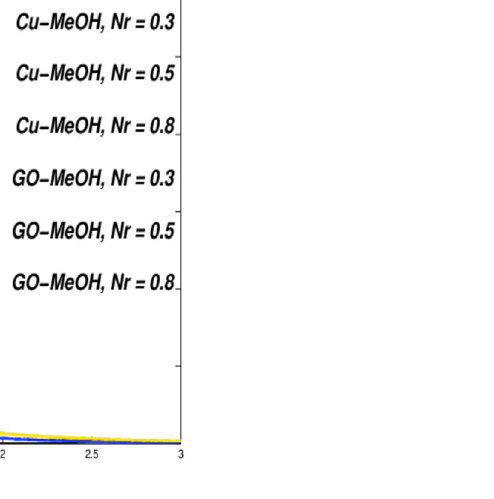
Figure 21. Entropy variation versus Nr